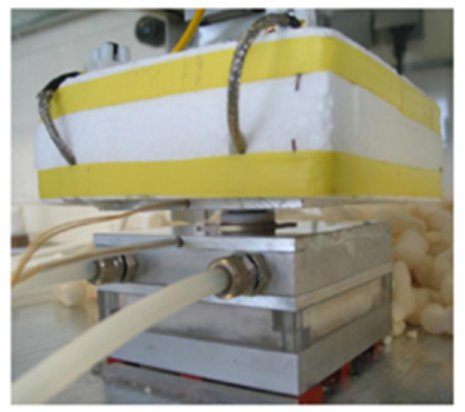
Figure 2. Divided-bar thermal apparatus for the determination of the thermal